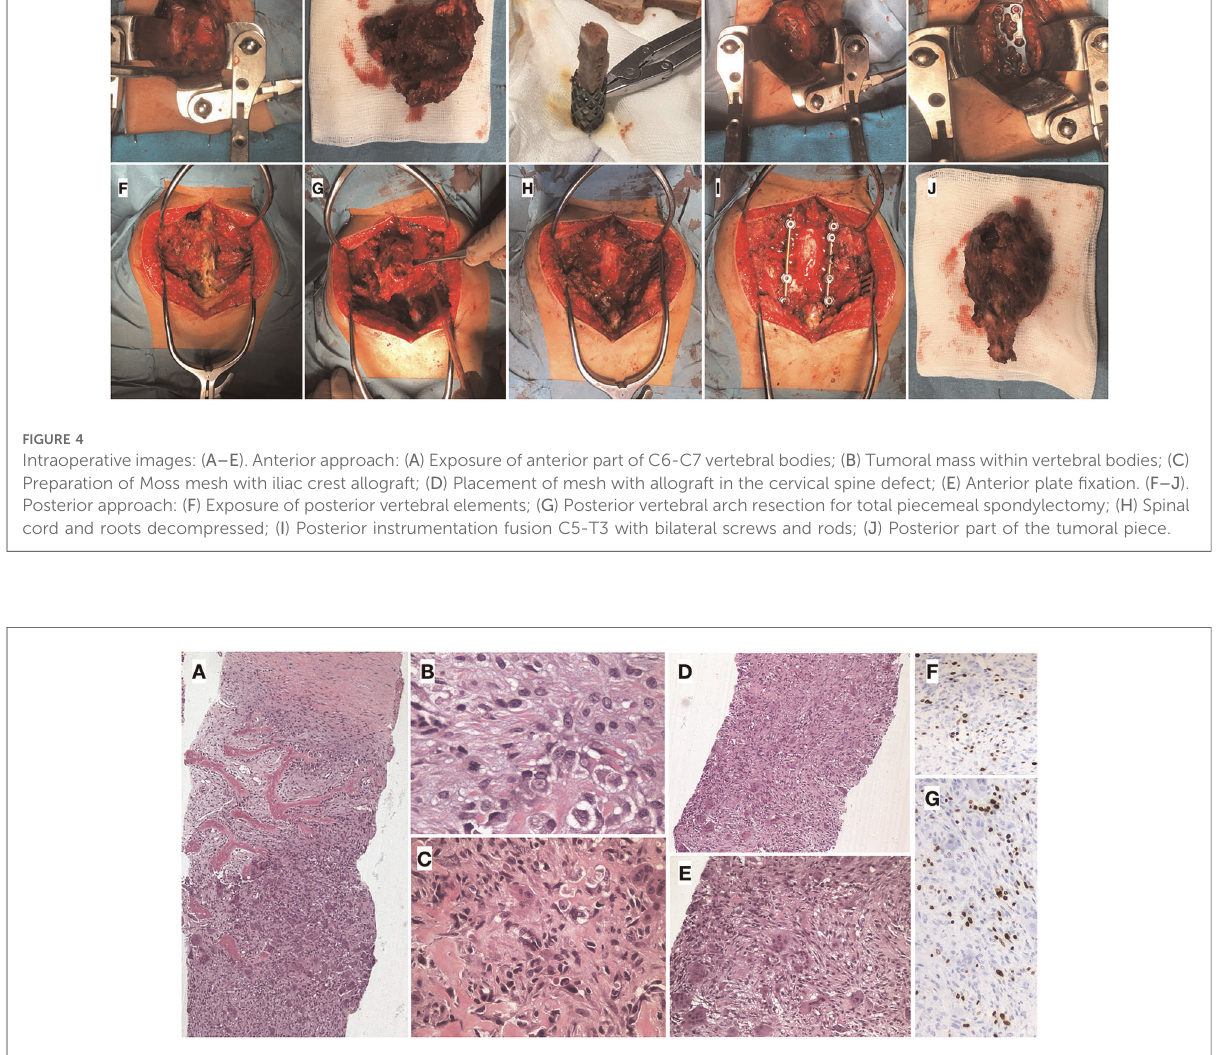
FIGURE 5 Resected tumor histology of the patient. ( A ) Plexiform and fi brous bone tissue in fi ltrated by solid neoplastic proliferation (HE, 40x). ( B ) Tumor cells with fusiform and epithelioid morphology with marked cellular atypia and numerous mitotic fi gures (HE, 400x). ( B,C ) Malignant cells are surrounded by fi brovascular stroma and subtle osteoid deposits (HE, 400x, 200x). ( D,E ) Numerous osteoclastic multinucleated giant cells are identi fi ed (HE, 100x, 200x). ( F,G ). Expression of the Ki-67 proliferation